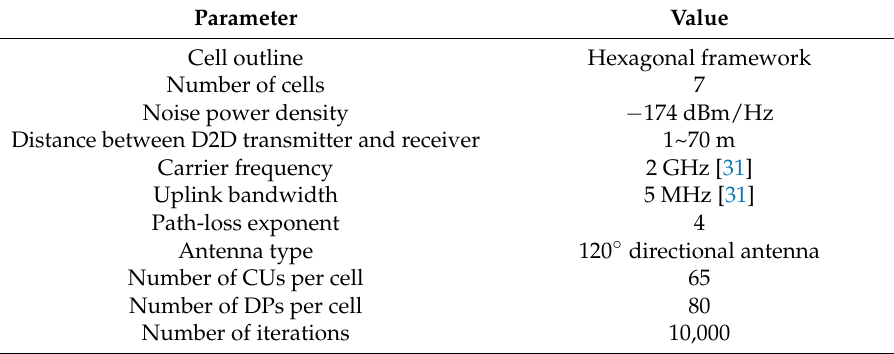
Table 1. Primary simulation parameters.